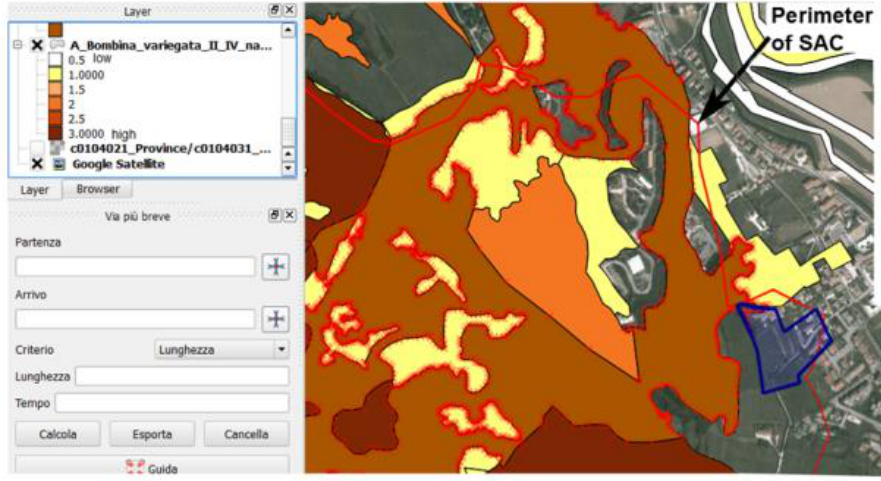
Figure 9. Example of the overlap of an area with a plan and project (blue) with areas of the potential distribution map (color map) and the Natura 2000 network (red perimeter). Distribution areas with a value of three (dark brown) indicate high suitability. Areas with a value of 0.5 (white) indicate low suitability. SAC, Special Area of